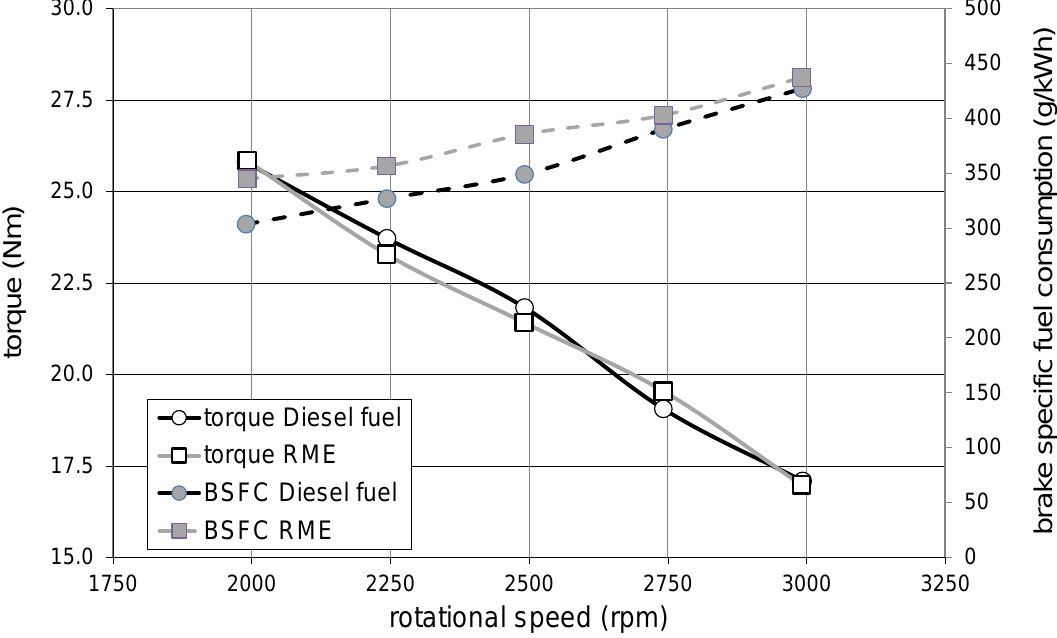
Figure 4. Engine torque and BSFC as a function of the rotational speed for the two tested fuels.